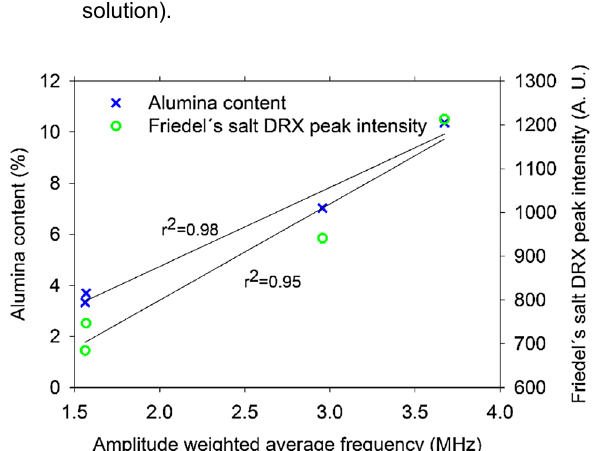
Fig. 12 Average energy of the ultrasonic response of pastes 14 days after vacuum saturation with a 2.8 mol/L NaCl solution, versus its corresponding alumina and bound chloride concentration.